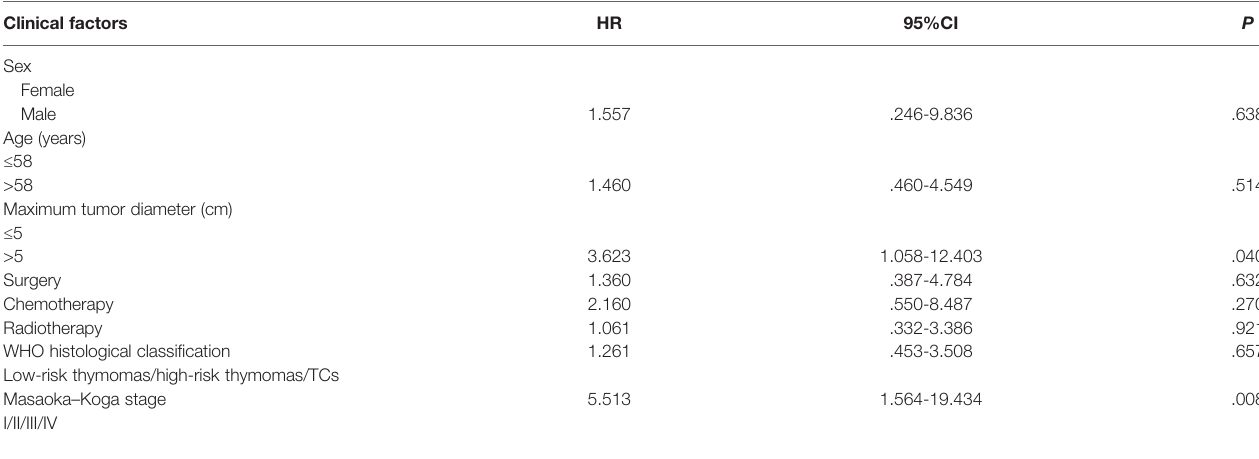
TABLE 3 | Multivariate analyses of overall survival for 84 patients with TETs